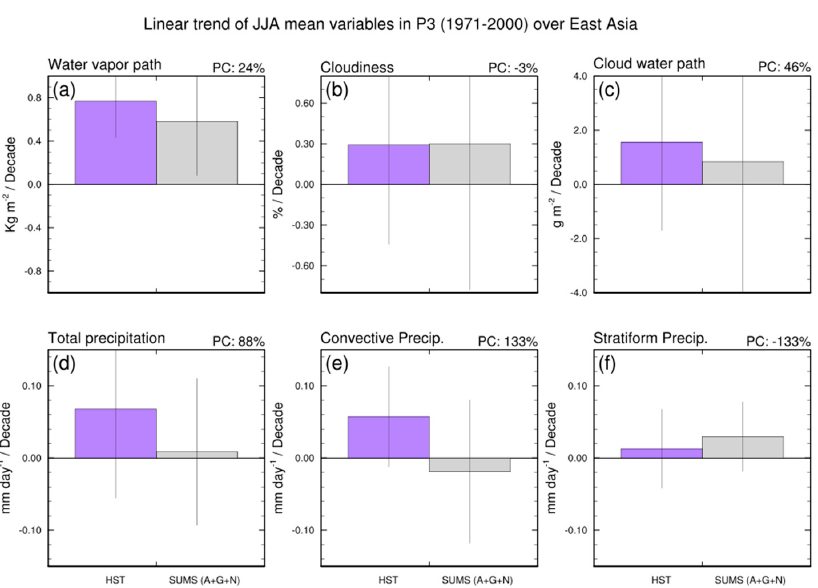
Figure 11. The linear trends of the JJA-mean variables; ( a ) water vapor path; ( b ) total cloud fraction; ( c ) cloud water path; ( d ) total precipitation rate; ( e ) convective precipitation rate; ( f ) stratiform precipitation rate; in combined all-forcing runs (HST; purple bar) and the sum of single-forcing simulations (anthropogenic aerosol, GHGs, and natural forcing; gray bar) for P3 (1971–2000) over East Asia (20 ◦ –50 ◦ N and 110 ◦ –140 ◦ E). Error bars indicate the standard deviation of CMIP5 models MME. The percentage change PC in % {(HST-SUMS) /| HST | } has been shown in the right corner.